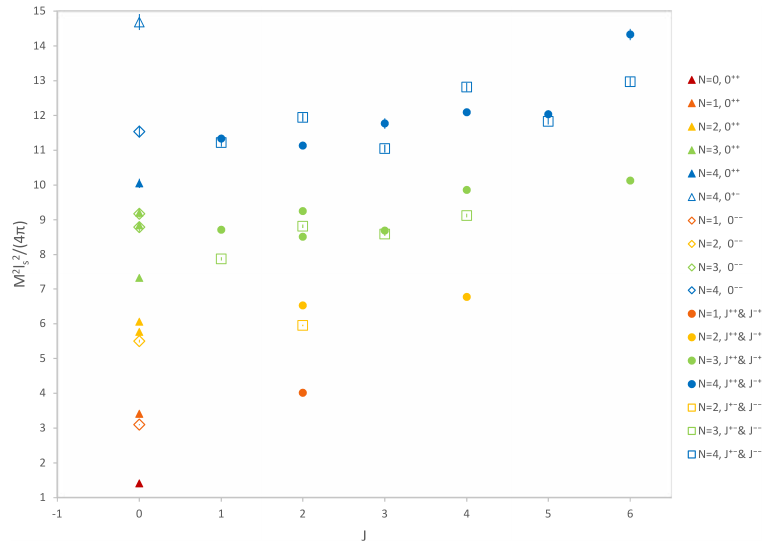
Figure 4 . Lattice results for glueball masses and quantum numbers [5]. For level N = 4 we included one state only for each set of quantum